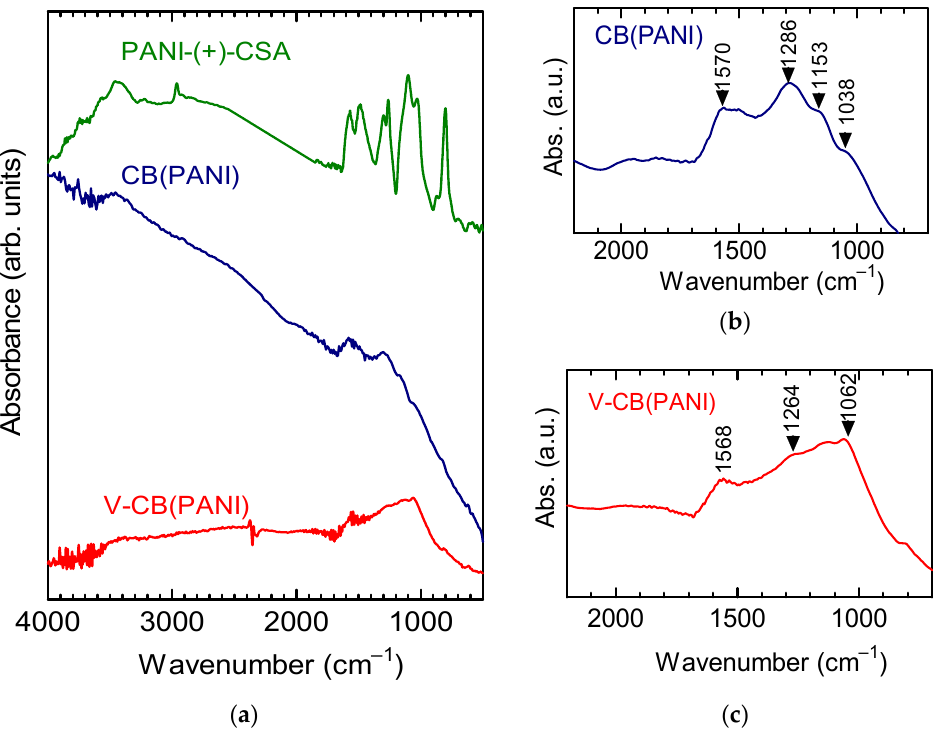
Figure 9. Infrared absorption spectra of PANI-(+)-CSA, CB(PANI), and V-CB(PANI). ( a ) Absorptions at 500–4000 cm − 1 ; ( b ) Magnification for the absorption of CB(PANI). ( c ) Magnification for the absorption of V-CB(PANI).